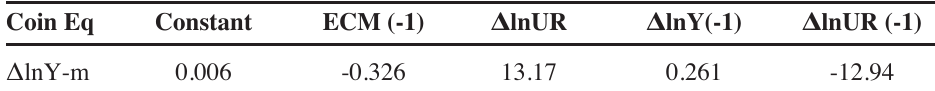
Results of Error Correction